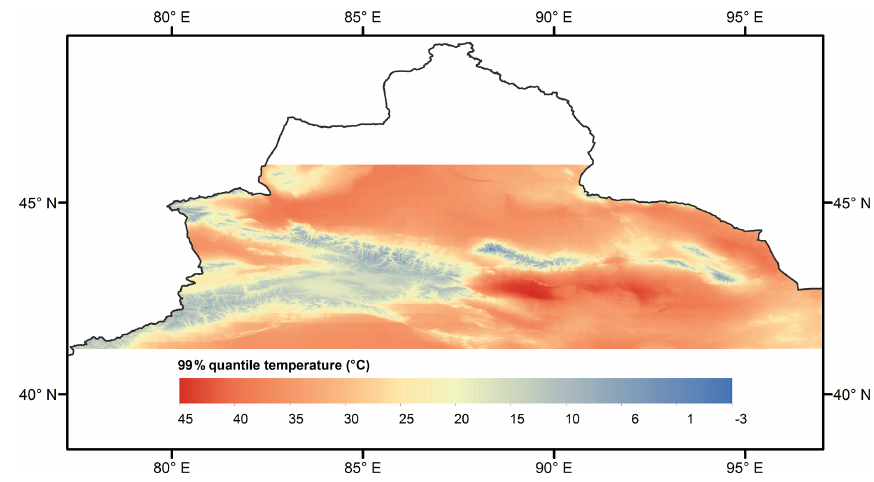
Figure 7. The 99% quantile temperature of the entire CTM based on the high-resolution data set.